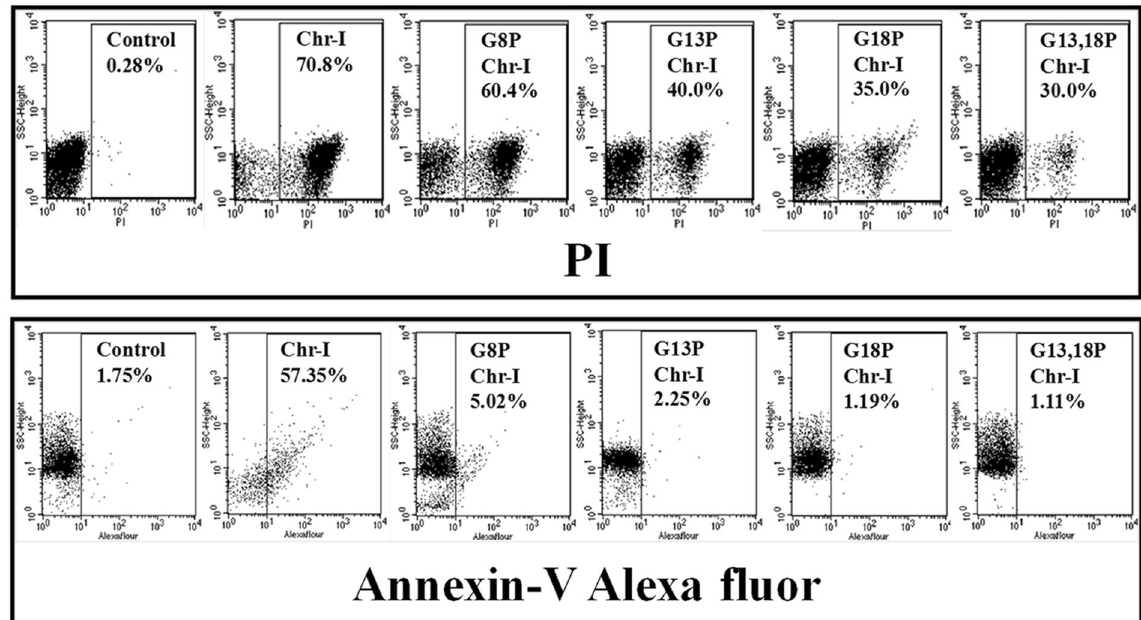
Figure 2. Determination of peptide-induced membrane damage of E. coli (ATCC 25922) cells and hRBCs by Chrysophsin-1 and its analogs. In the upper panel, the ctrl dot blot shows the autofluorescent E. coli cells. Left quadrant depicts the unstained bacterial cells whereas right quadrant depicts PI-stained cells. Concentrations of the peptides were 5 μ M. In the lower panel, left quadrant of each blot represents unstained hRBC cells, whereas the lower right quadrant depicts the stained hRBC cells. Concentration of each of the peptides was 25 μ M. 10,000 events were recorded for each sample.